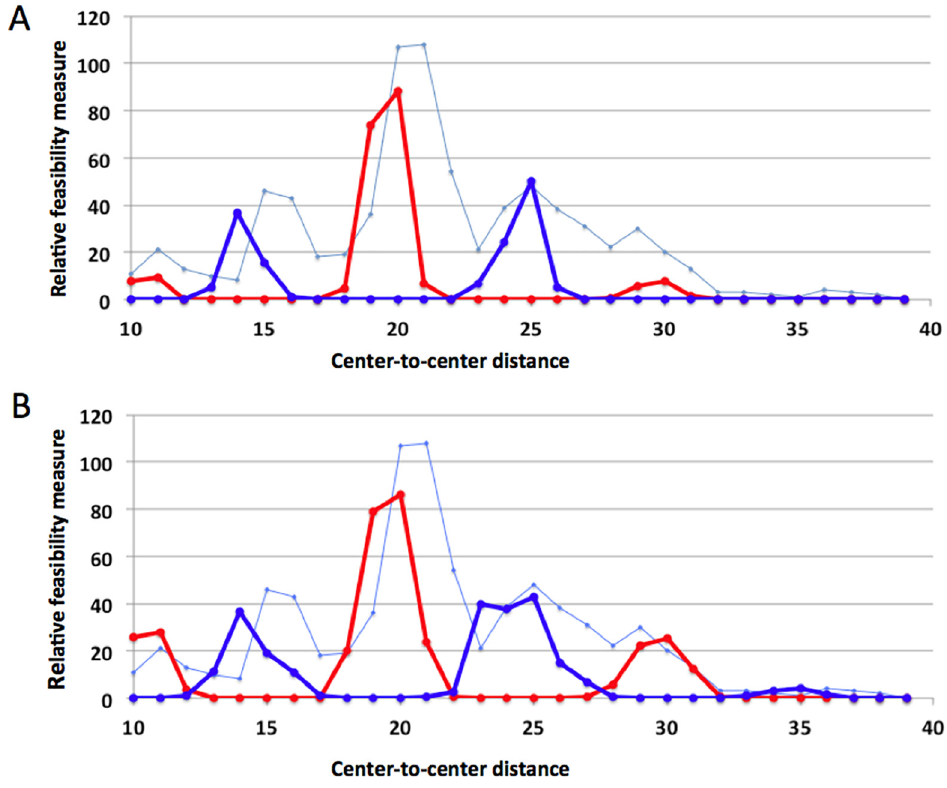
Fig 6. Computed scaled feasibility measures of the tetramer formation vs. CTCD using two NDDs ( A ) or at least one NDD ( B ) using the DNA with 10.0 bps per helical turn.